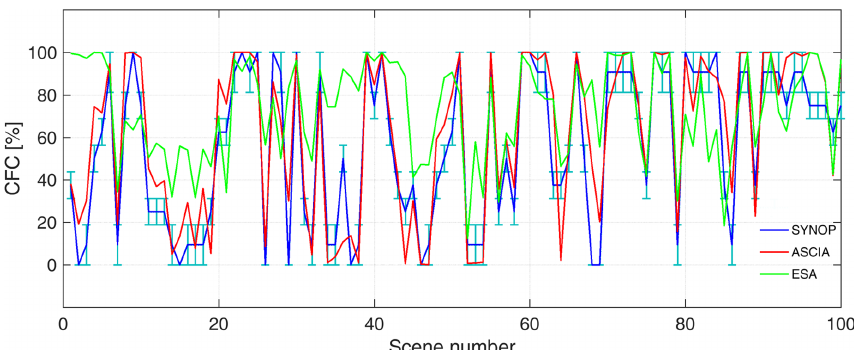
Figure 16. CFC in percent by ASCIA (red), SYNOP (blue) and ESA Cloud Product (green) for 100 scenarios in March, May and July 2008 over Svalbard and Greenland. Light-blue error bars show the range of percentage values for each okta from SYNOP measurements.